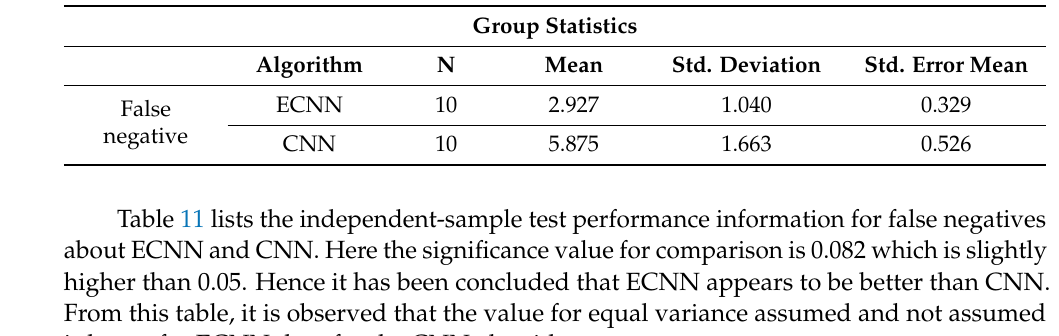
Table 10. Group statistics parameter comparison for false negative between ECNN and CNN.